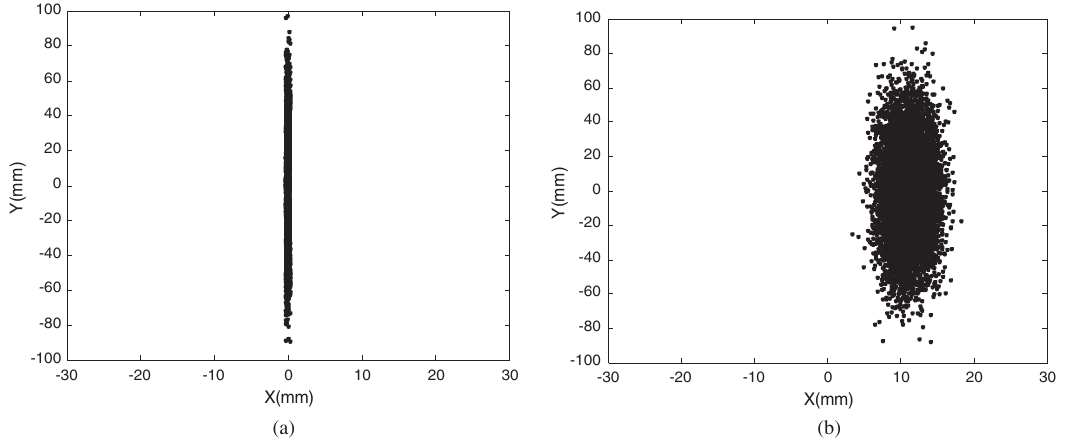
FIG. 4. Numerical simulation result of beam profile at EFP. (a) without momentum offset. (b)with 2% momentum